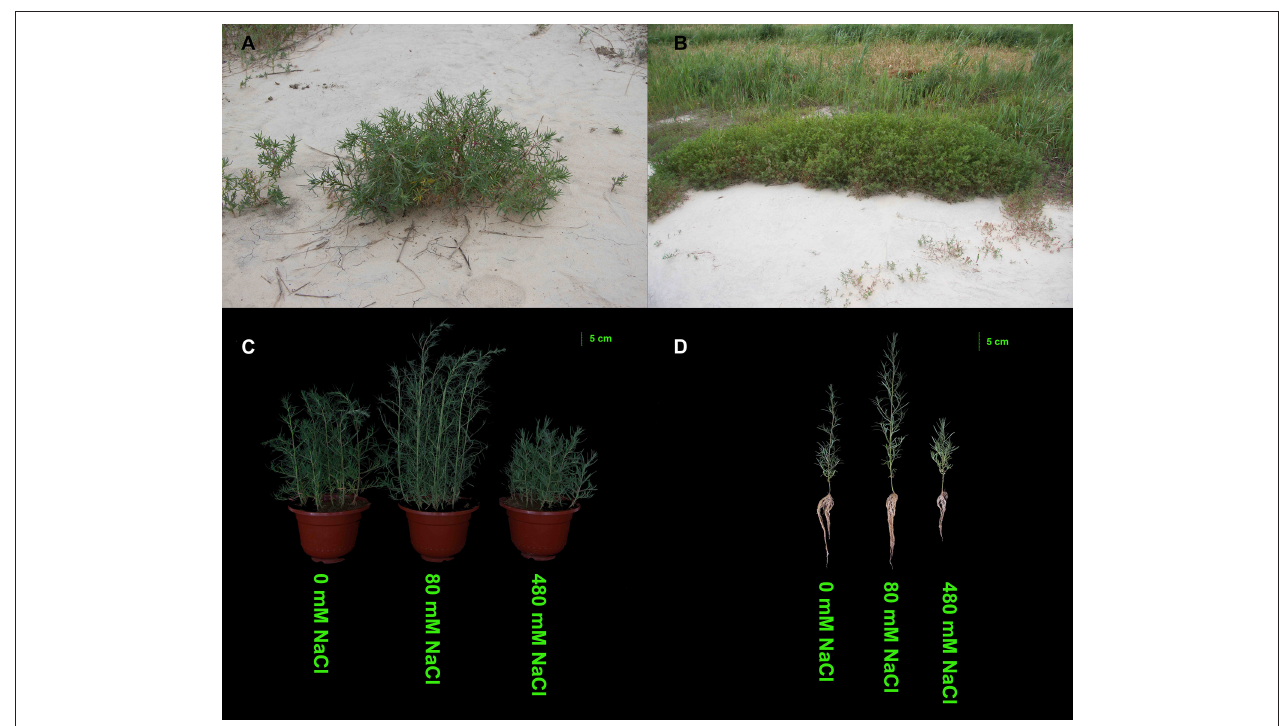
FIGURE 3 | Effects of salinity stress on the growth of K. sieversiana . (A,B) Growth status of K. sieversiana in its natural saline–alkaline habit. (C,D) Effects of various concentrations of NaCl on the growth of K. sieversiana . The 30-d-old K. sieversiana seedlings were treated with various concentrations (0, 80, and 480mM) of NaCl for 30 d. The growth status of K. sieversiana under NaCl stresses.